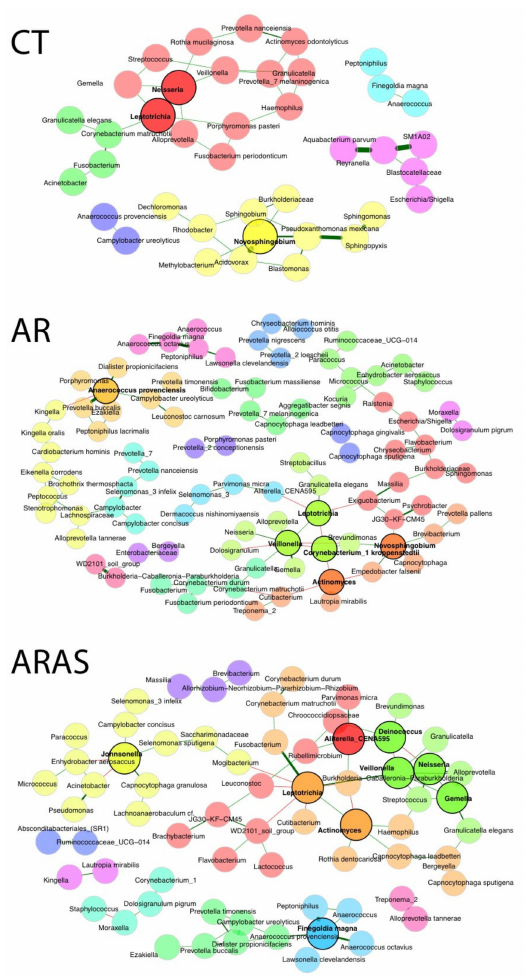
Figure 4. Co-occurrence networks of bacterial taxa in the nasal bacteriome of participants with rhinitis with comorbid asthma (ARAS), allergic rhinitis (AR) and healthy controls (CT). Nodes represent taxa connected by edges whose width is proportional to the strength of their association. Green and red edges indicate positive and negative correlations, respectively. Nodes within the 90th percentile of degree connectivity are considered hub nodes (black circle line). Inferred modules or subnetworks are colored